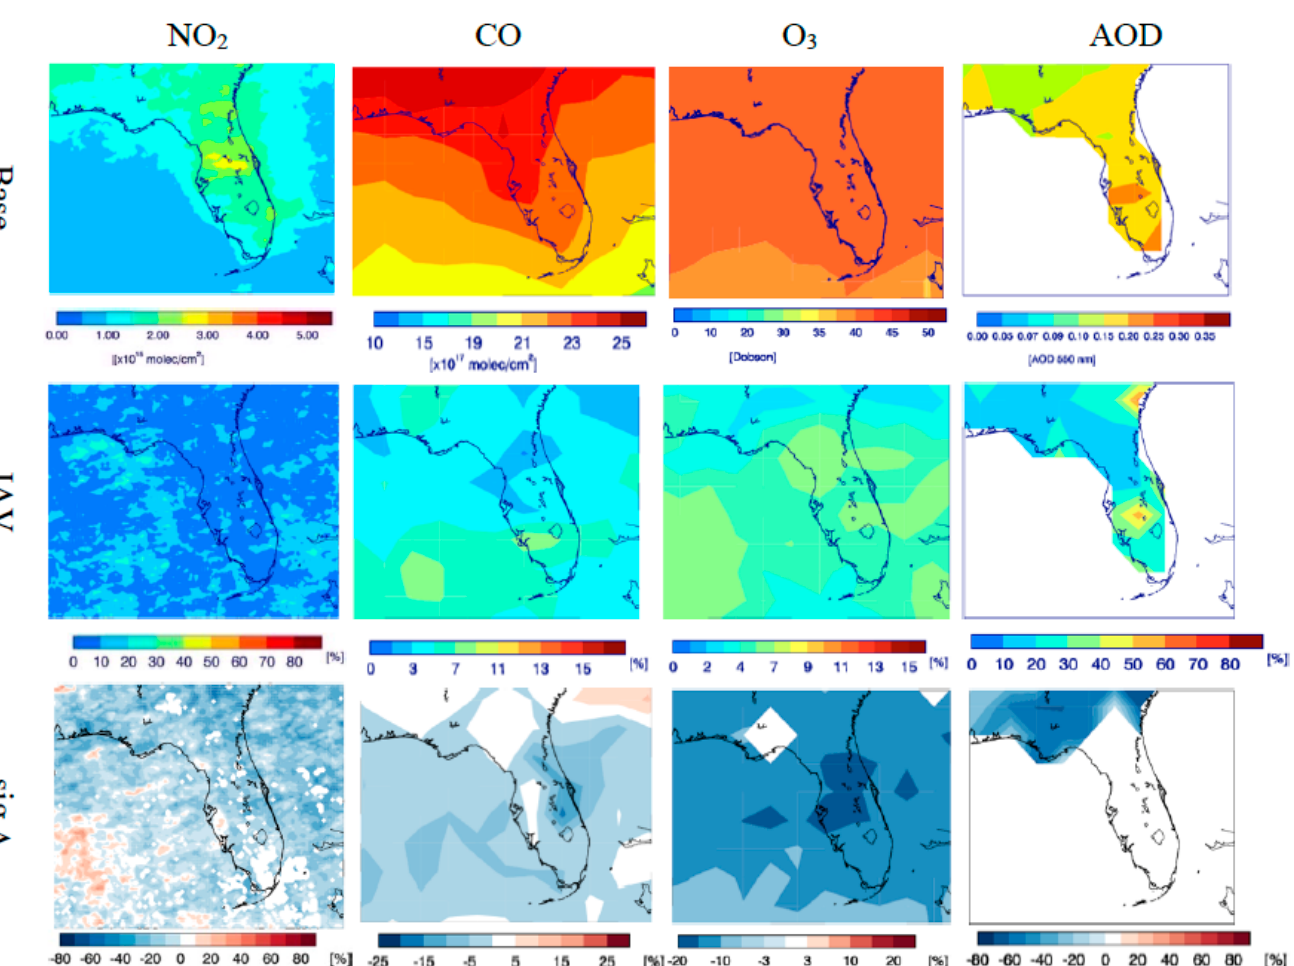
Figure 8. Same as Figure 3, but for the southeastern US (FL).